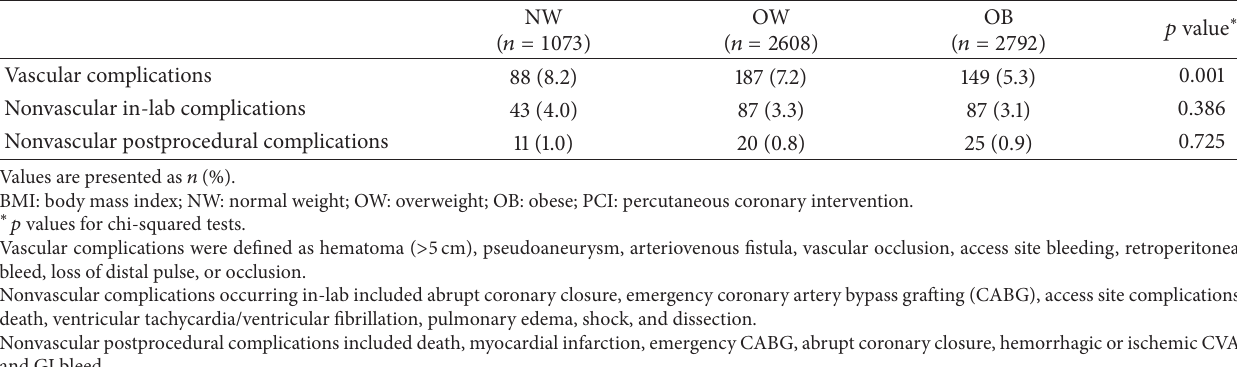
Table 4: Vascular and nonvascular complications occurring within 24 to 48 hours in patients undergoing PCI according to BMI category.